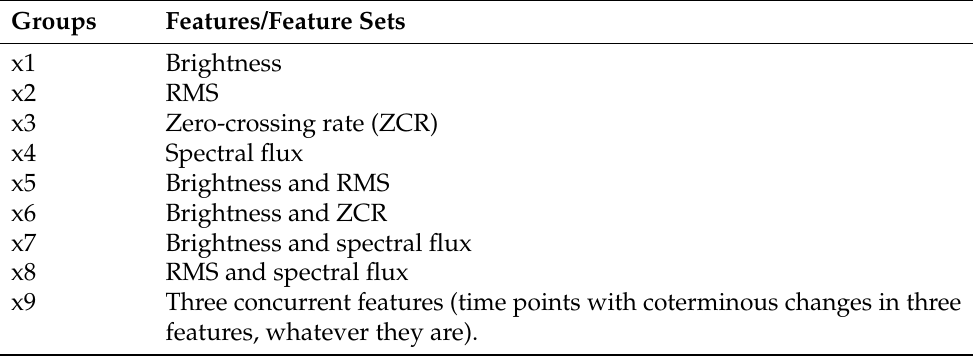
Table 1. Features and feature sets under consideration and their